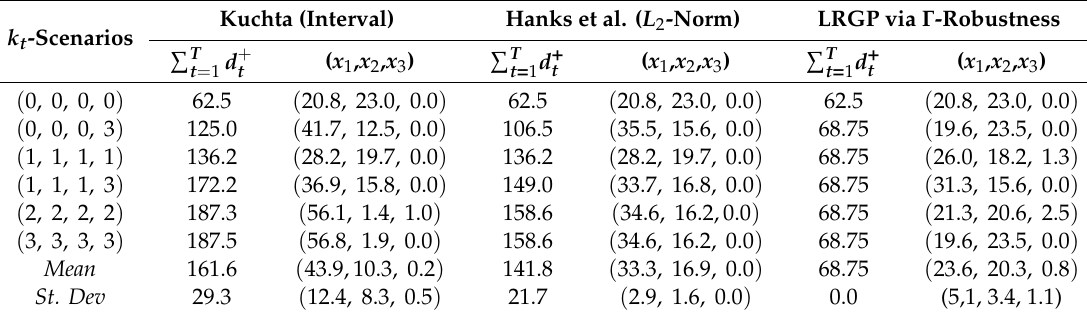
Table 3. Comparison of Kuchta (interval), Hanks et al. ( L 2 -norm), and light robust goal programming (LRGP) ( Γ -robustness) models.